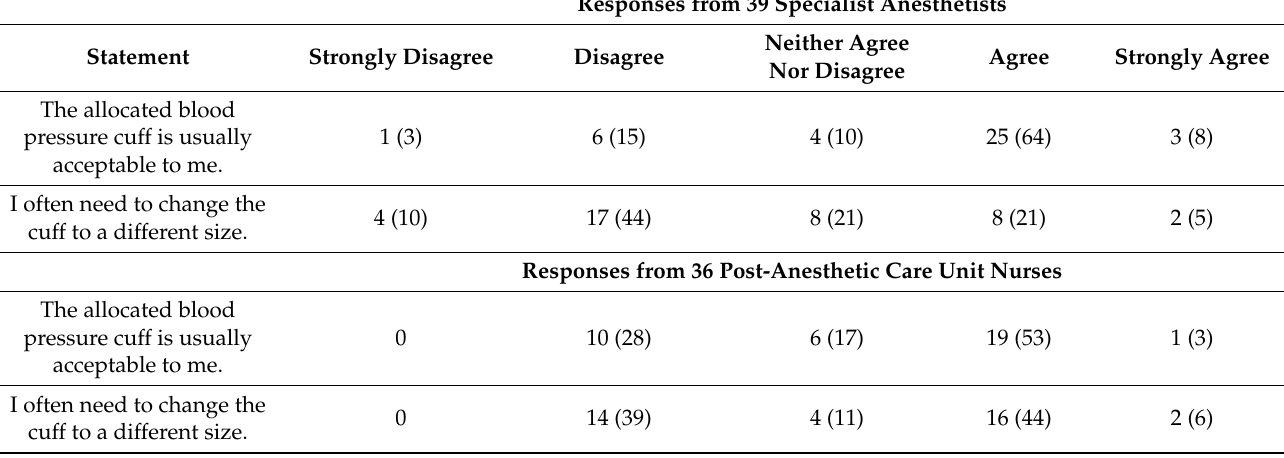
Table 5. Statements and Likert scale responses from specialist anesthetists and PACU staff following implementation of the intervention. Expressed as number